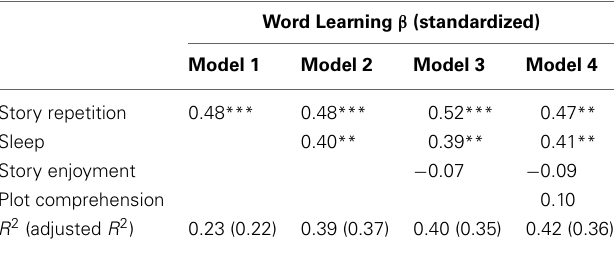
Table 5 | A series of regression models predicting children’s word retention 24h after story exposure based on story repetition, sleep, story enjoyment and plot comprehension.